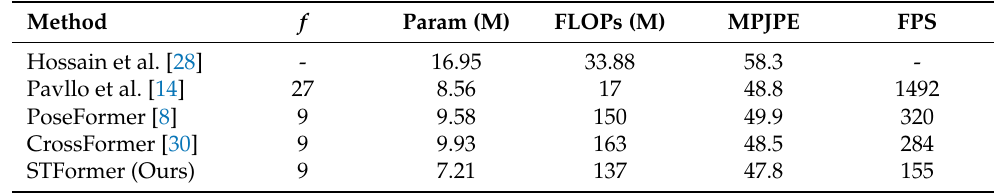
Table 2. Comparison between the proposed method with a set of previous methods in terms of floating-point operations (FLOPs), number of the parameters, MPJPE, and frames per second (FPS). The experiments were conducted on Human3.6M under Protocol 1 with the CPN-detected 2D pose as the